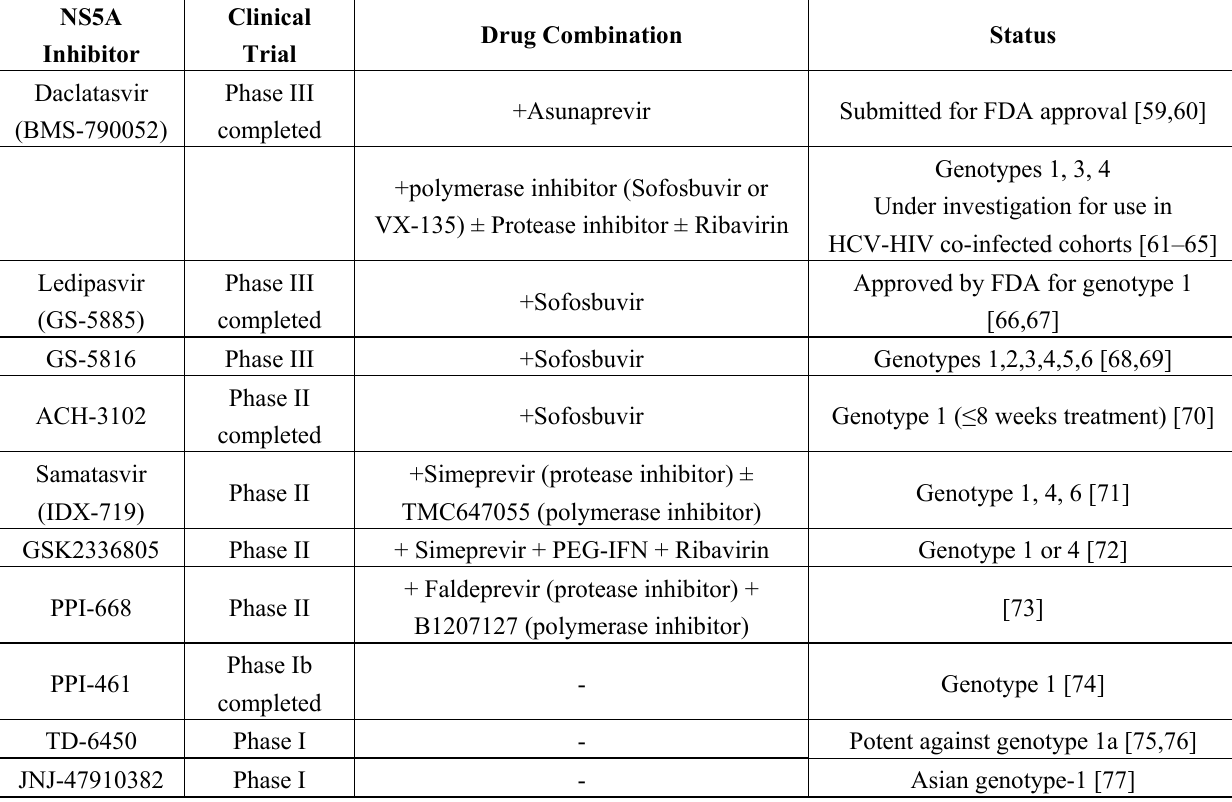
Table 1. HCV NS5A inhibitors currently in clinical